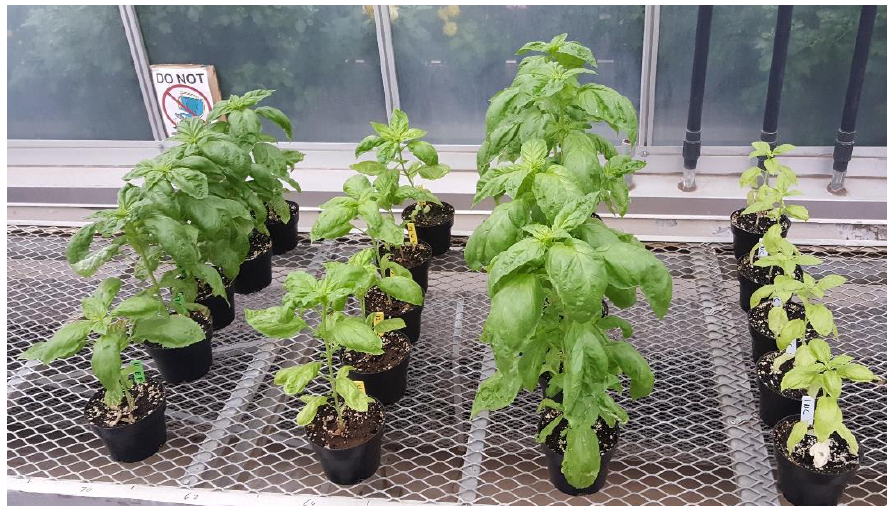
Figure 3. Image of ‘Nufar’ basil plants (day 42) grown in University of Minnesota’s Plant Growth Facilities greenhouse (St. Paul, MN). Plants were grouped by fertility treatment in rows; from left to right: digested wastewater, raw wastewater, inorganic fertilizer, and no fertilizer.